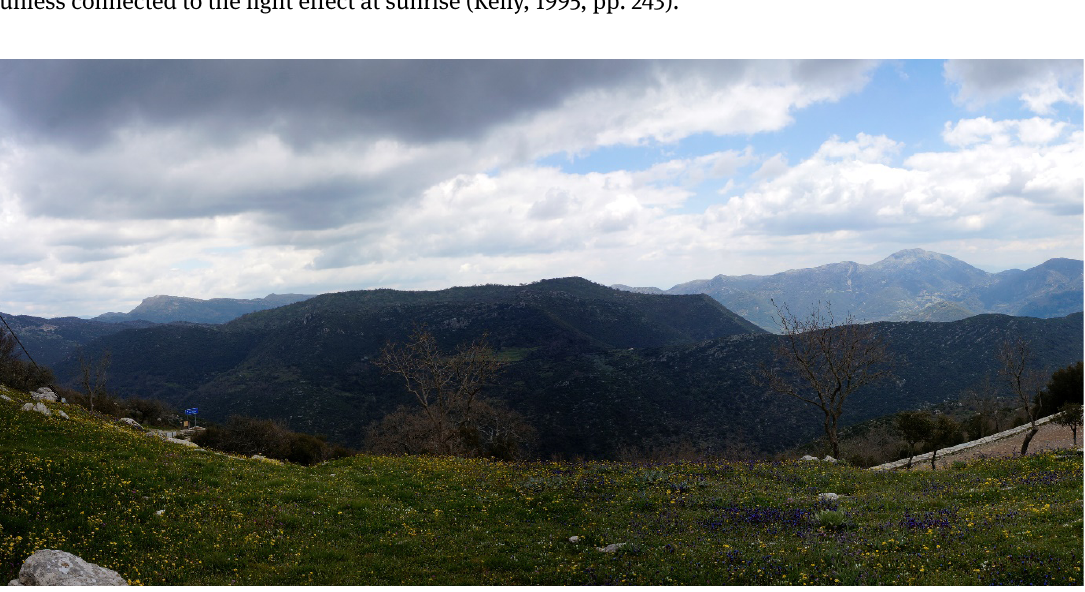
Figure 1. Bassae NE–E horizon of Classical temple. (Photo by E. Boutsikas).